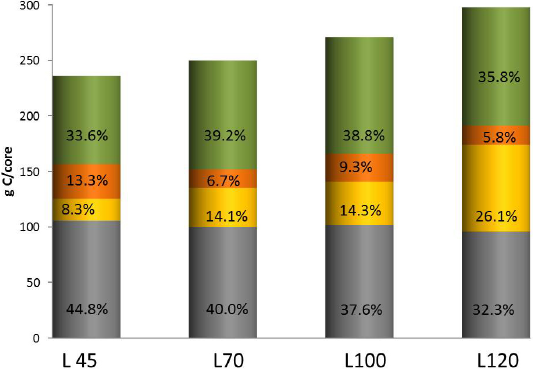
Figure 5. C content in each core (L45, L70, L100 and L120) orig- inated from C4-SOC (grey columns), C 3 -SOC from worm activity (yellow columns), C 3 -SOC from DOC leaching (orange columns) and C litter (green